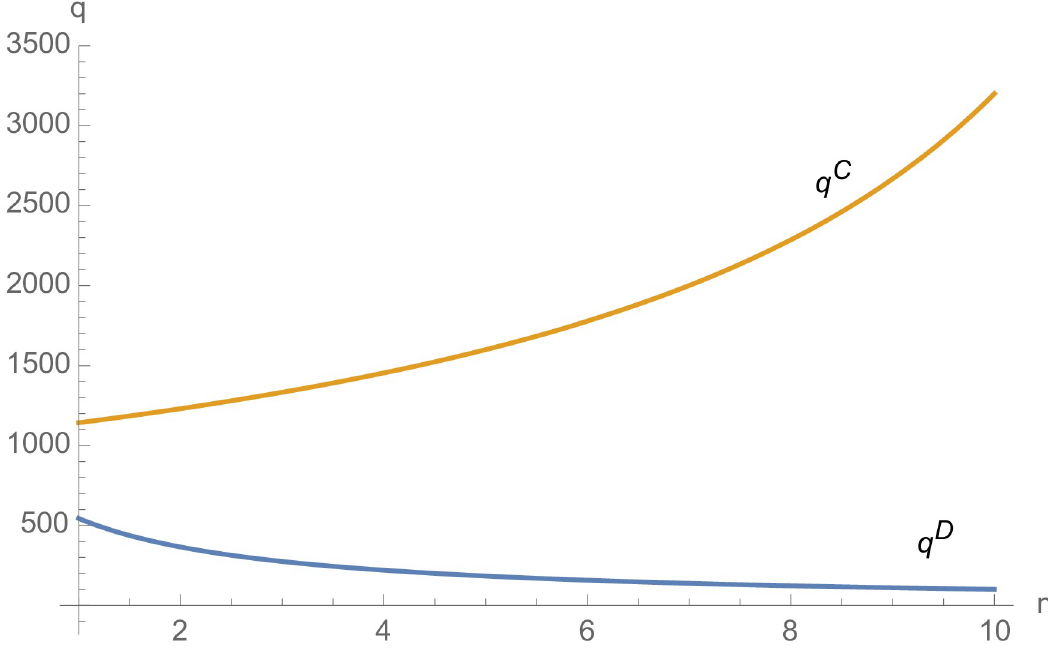
Fig 34. The impact of n on q .